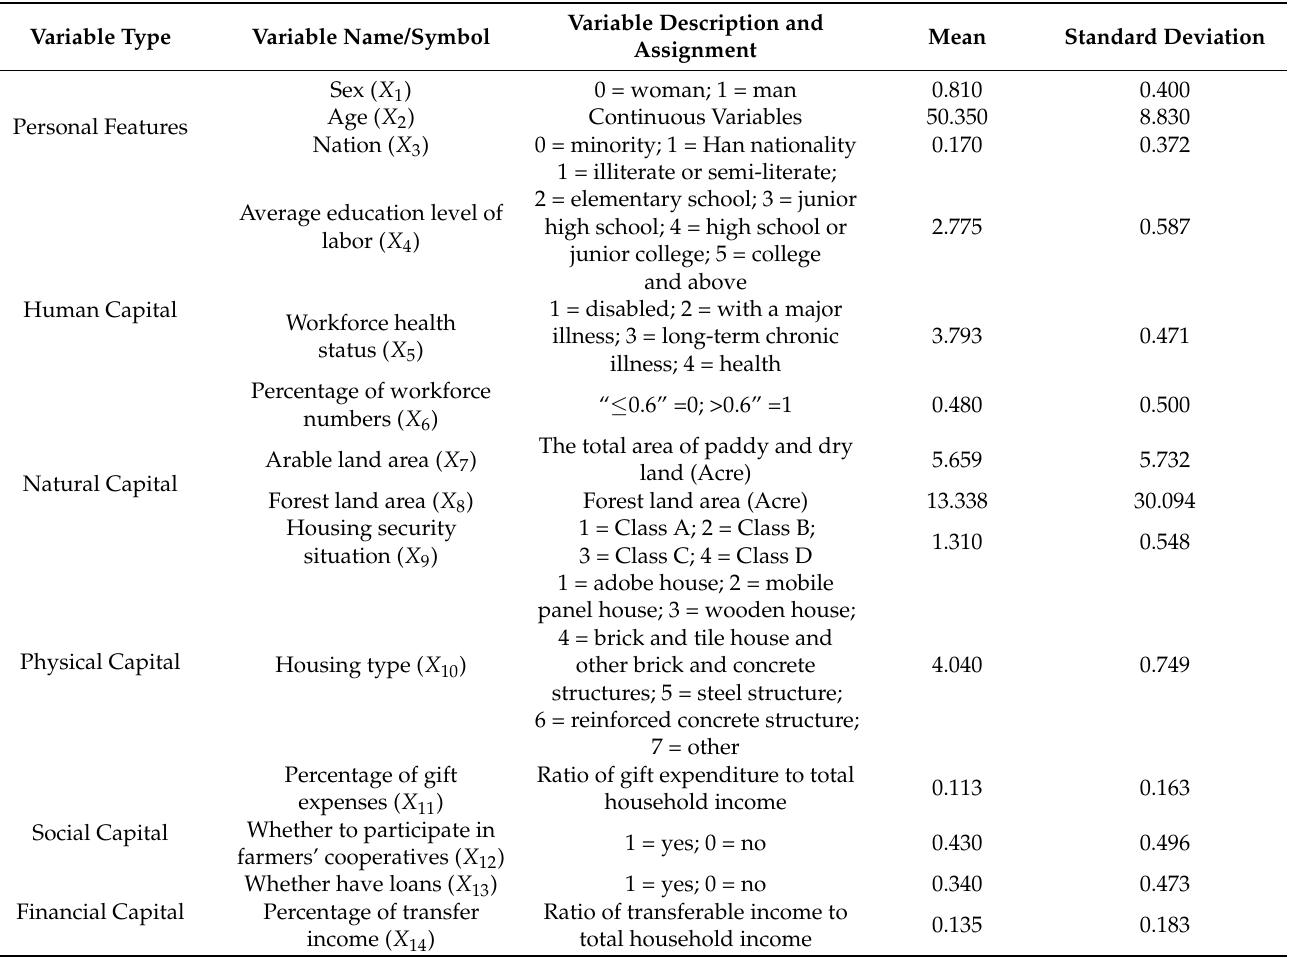
Figure 2. Mechanism framework of returning to poverty. Table 1. Variable definitions and descriptive statistics.